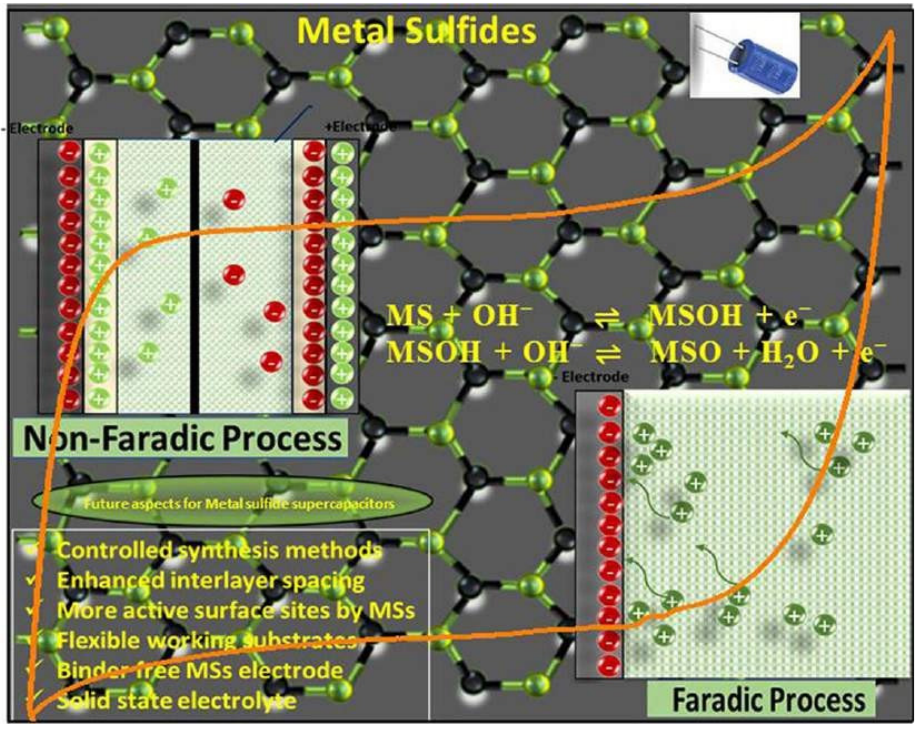
Figure 21. Challenges and opportunities for metal sulfide materials in supercapacitors. Reproduced with permission from [95].